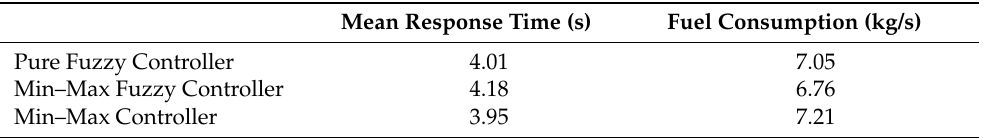
Table 6. Comparison between response time and fuel consumption for Pure Fuzzy Controller (PFC), Fuzzy Min-Max (FMM) controller, ans Min-Max